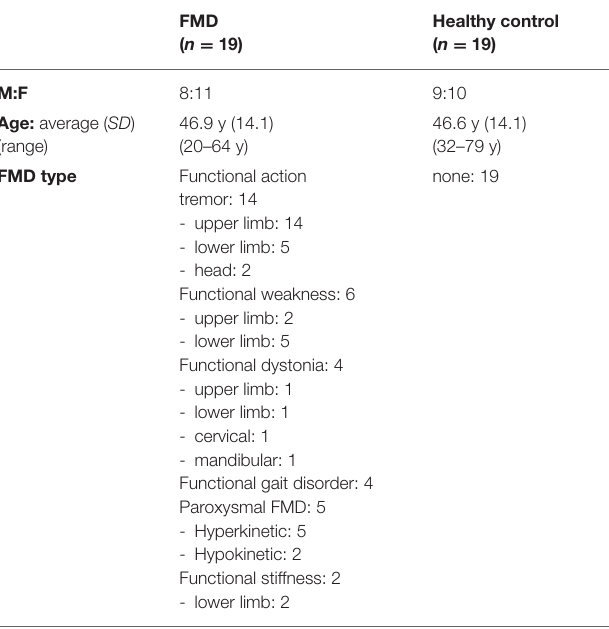
TABLE 1 | Study participant characteristics. TABLE 2 | Percentage of trials excluded as outliers in both the subliminal and supraliminal